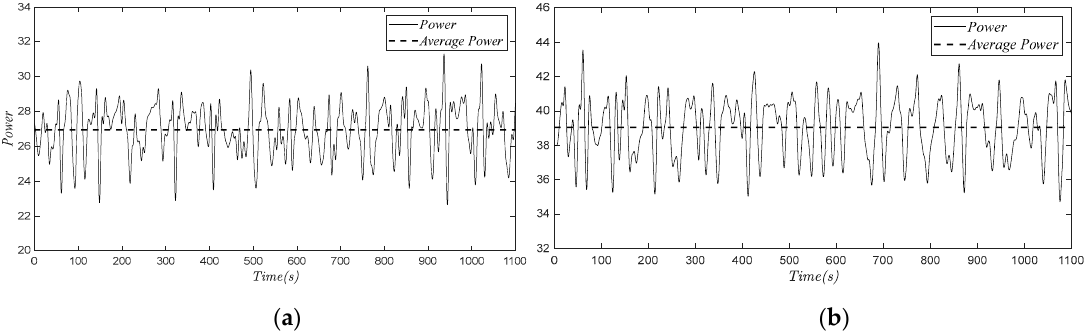
Figure 21. Cruise power data of the UAV with different payload configurations at altitude of 4700 m: ( a ) Small fixed-focus camera with low-power transmission, ( b ) optical-infrared combined optoelectronic pod with remote digital transmission.